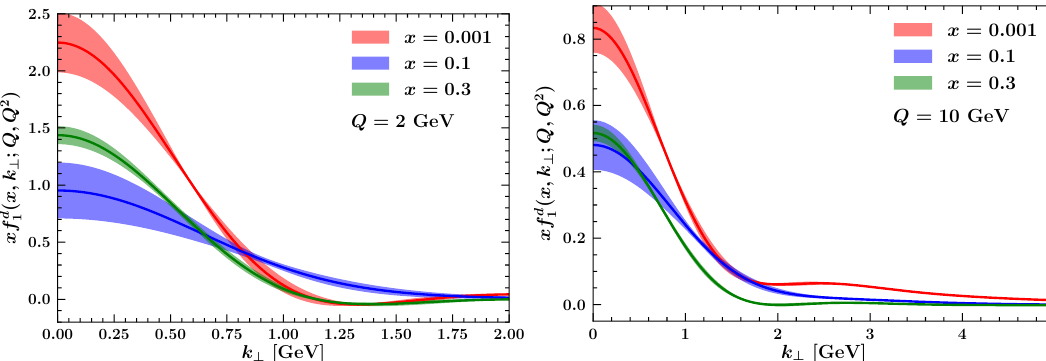
p (cid:16) = Q = 2 GeV (left plot) and 10 GeV (right